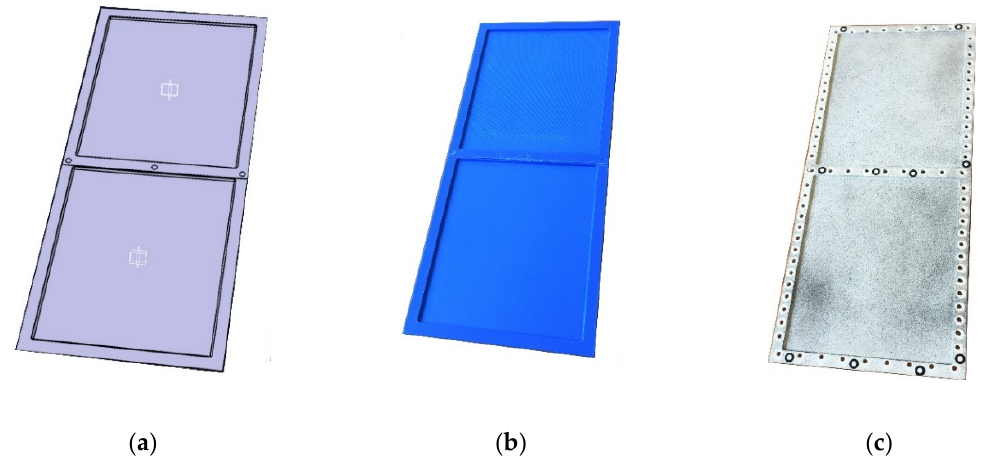
Figure 11. View of the torsion box wall: ( a ) CAD virtual model; ( b ) printed model before processing; ( c ) printed model prepared for assembly and optical scanning.